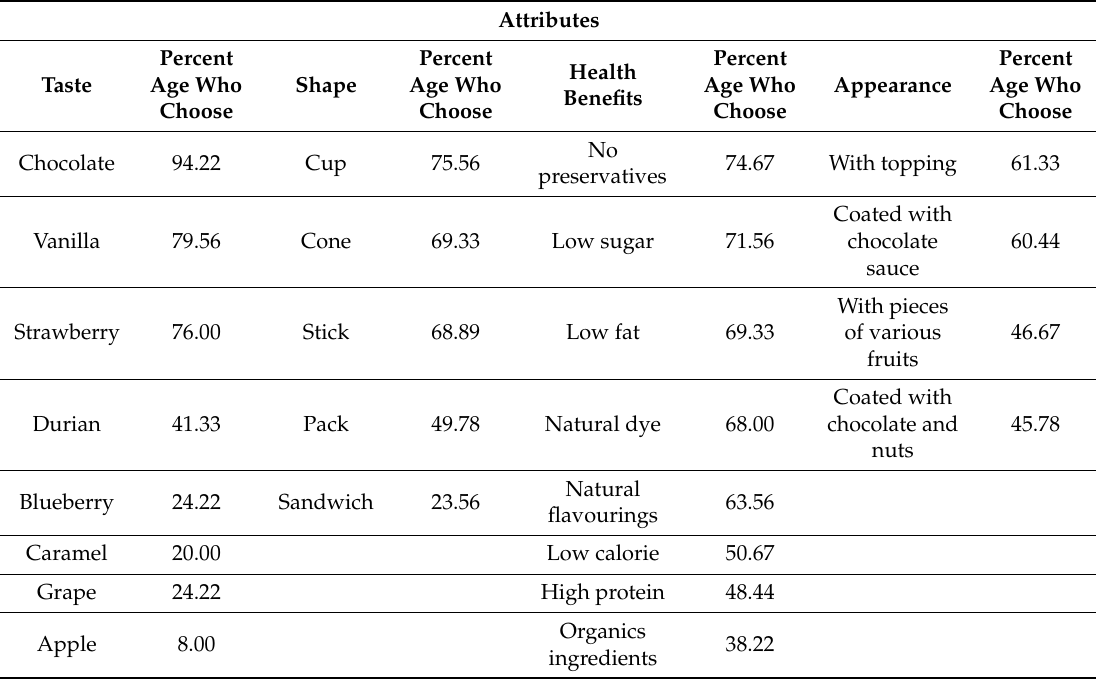
Table 4. Consumer Preferences for each variant in the